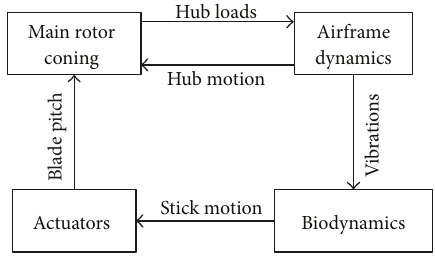
Figure 2: Vertical bouncing loop.